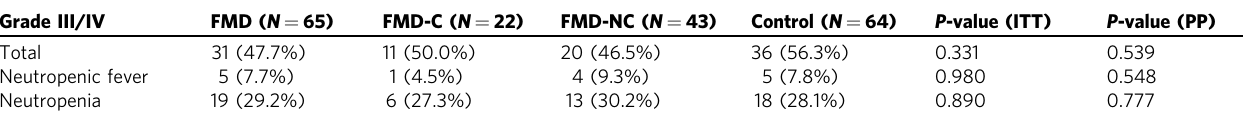
Grade III/IV side effects were scored according CTCAE4.03. Each side effect was scored maximal once per patient during the course. FMD fasting mimicking diet, C compliant, NC not compliant, ITT intention to treat, PP per protocol, CT chemotherapy.